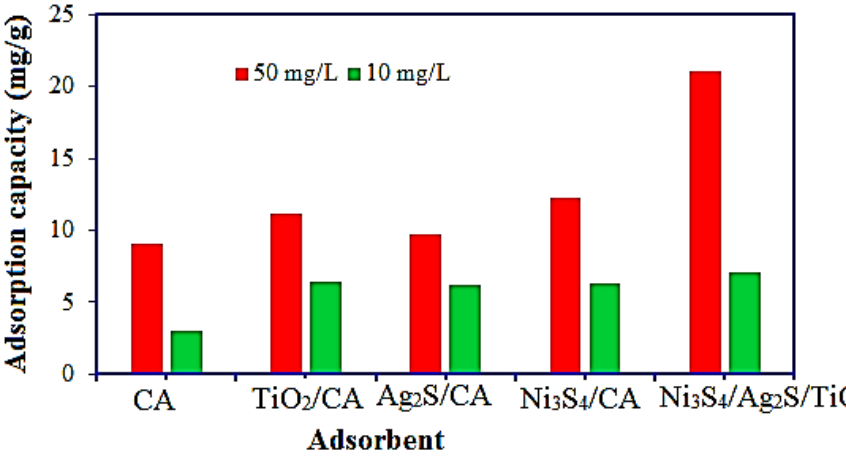
Figure 8. Comparison of the adsorption efficiencies of synthesized aerogels for the removal of OTC. (aerogel mass: 0.03 g, OTC volume: 30 mL, time: 180 min, pH: 6). The adsorption of OTC onto Ni 3 S 4 /Ag 2 S/TiO 2 /CA aerogel was investigated at pH